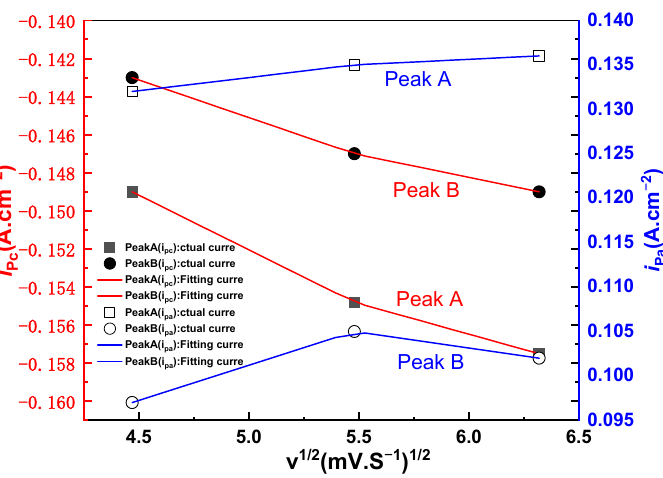
Figure 3. Relationship between i pc and v 1/2 of Fe electrode in NaCl-CaCl 2 -LiCO 2 molten salt